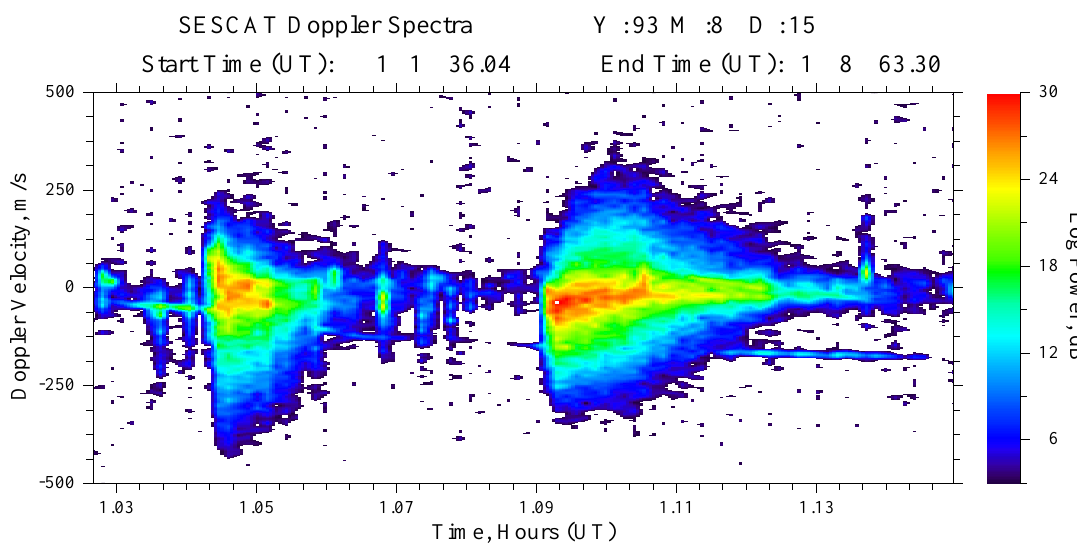
Fig. 8. Two more examples of long-lasting MIB Doppler spectrograms, but no evidence that the steep plasma gradients, which are expected to be present in MIB, lower the threshold for the FB